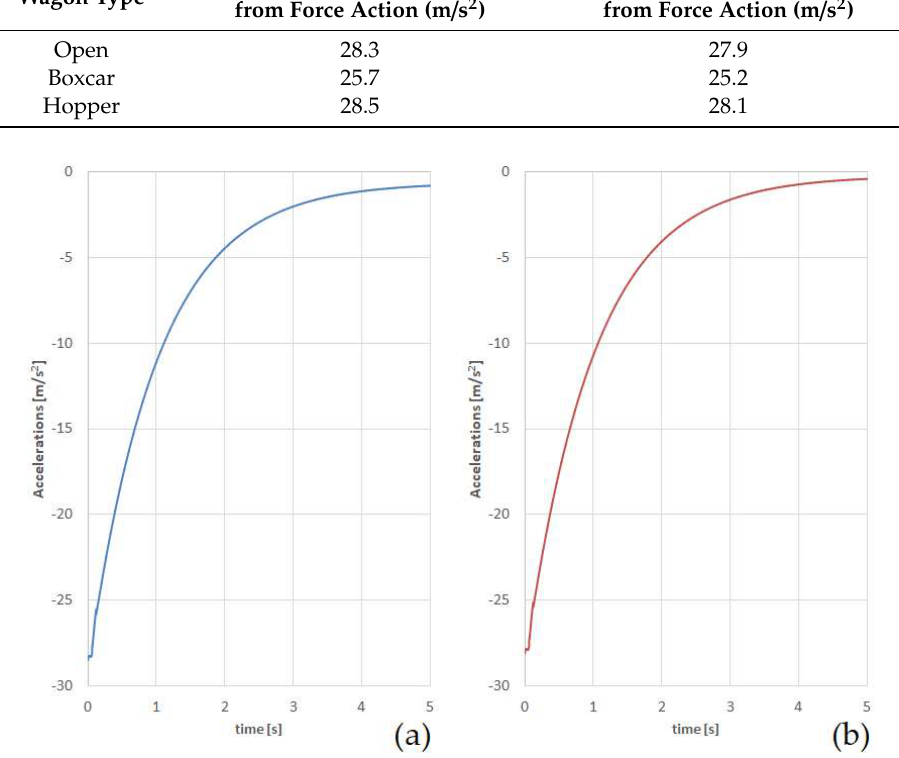
Table 1. Numerical values of accelerations on the carrying structure of articulated circular-tube wagons.